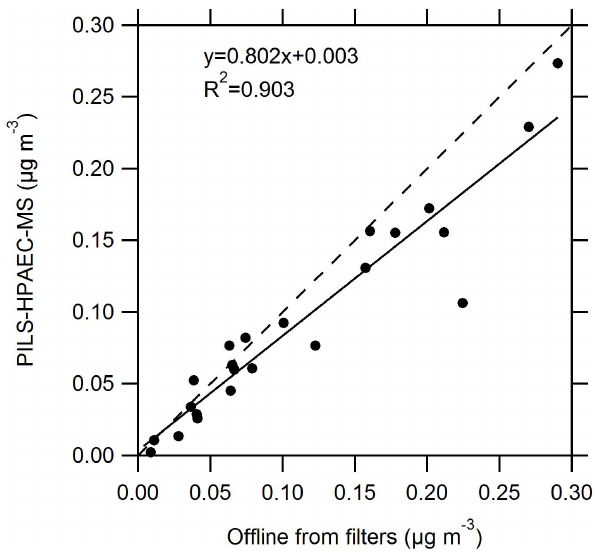
Fig. 5. Comparison of levoglucosan concentrations measured on- line with the PILS–HPAEC–MS (averaged over the filter sampling times) and the levoglucosan concentrations sampled with filters and analyzed offline with HPAEC–MS. The dotted line represents the 1:1 line.